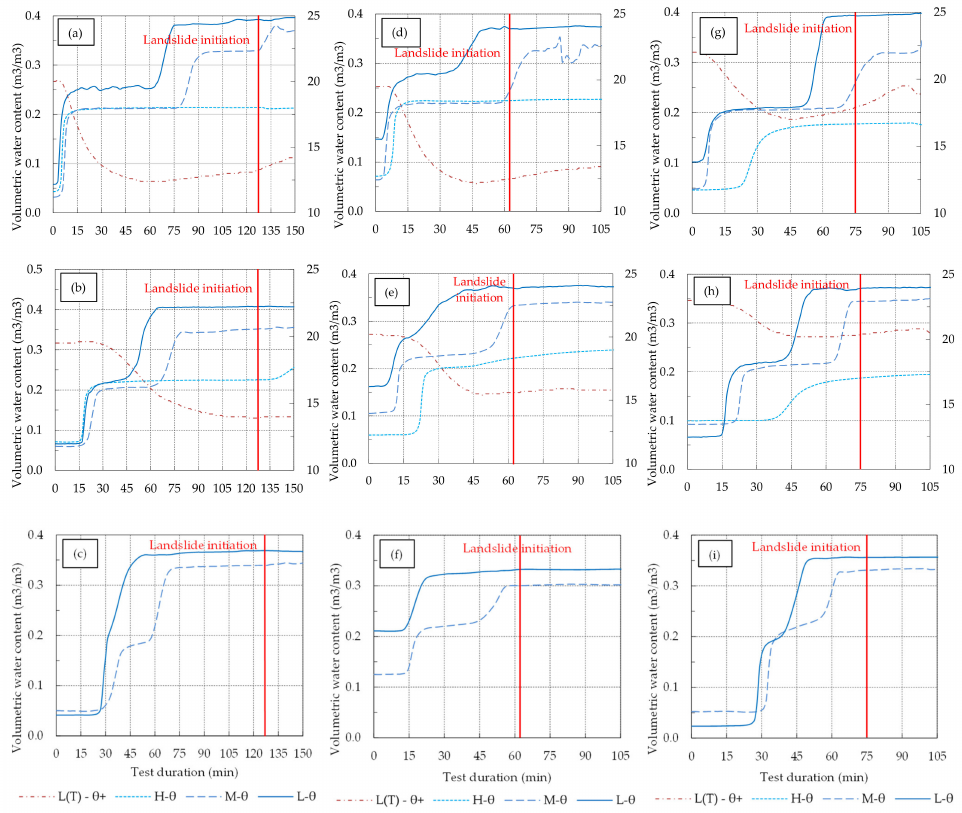
Figure 16. Diagrams of measured volumetric water content and temperature during tests at the following slope inclination and sensor depths: ( a ) 30 ◦ and 6 cm; ( b ) 30 ◦ and 18 cm; ( c ) 30 ◦ and 24 cm; ( d ) 35 ◦ and 6 cm; ( e ) 35 ◦ and 18 cm; ( f ) 35 ◦ and 24 cm; ( g ) 40 ◦ and 6 cm; ( h ) 40 ◦ and 18 cm; and ( i ) 40 ◦ and 24 cm. The depth of the sensors is 6, 18, and 24 cm from the surface, respectively. L, M, and H mark position of the sensors in part of the slope model, e.g., lower, middle, and upper